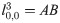
Intercept measurements for the point-sampled intercept method for a podocyte nucleus with concavity.Dashed lines represent the sampling grid superimposed on podocyte nuclei. One of the cross-points of this grid falling on the nuclear profile (here "P") is randomly selected(i.e., sampling point). The red line represents the random direction line, passing through the sampling point "P" along which the intercepts are measured. The intercepts include l0,03=AB, l0,i−3=PC, and l0,i+3=PD.